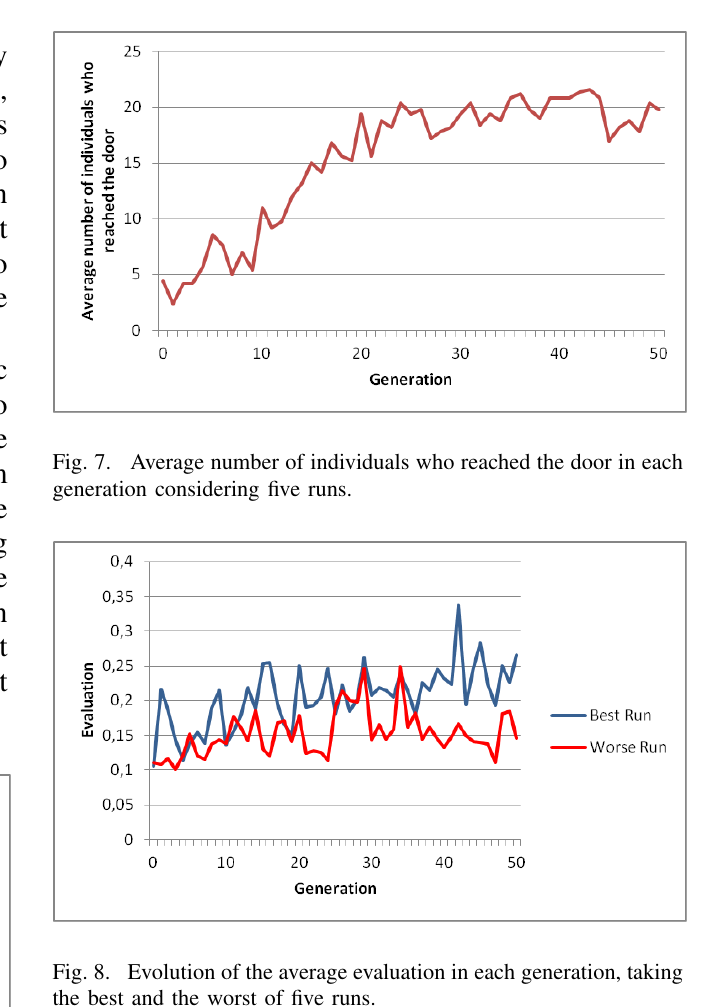
Fig. 8. Evolution of the average evaluation in each generation, taking the best and the worst of five